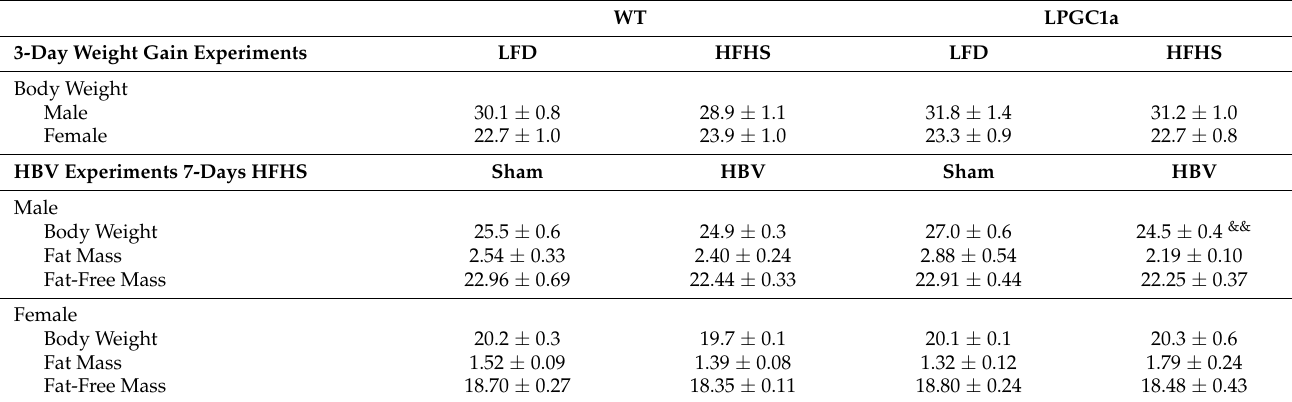
Table 2. Initial